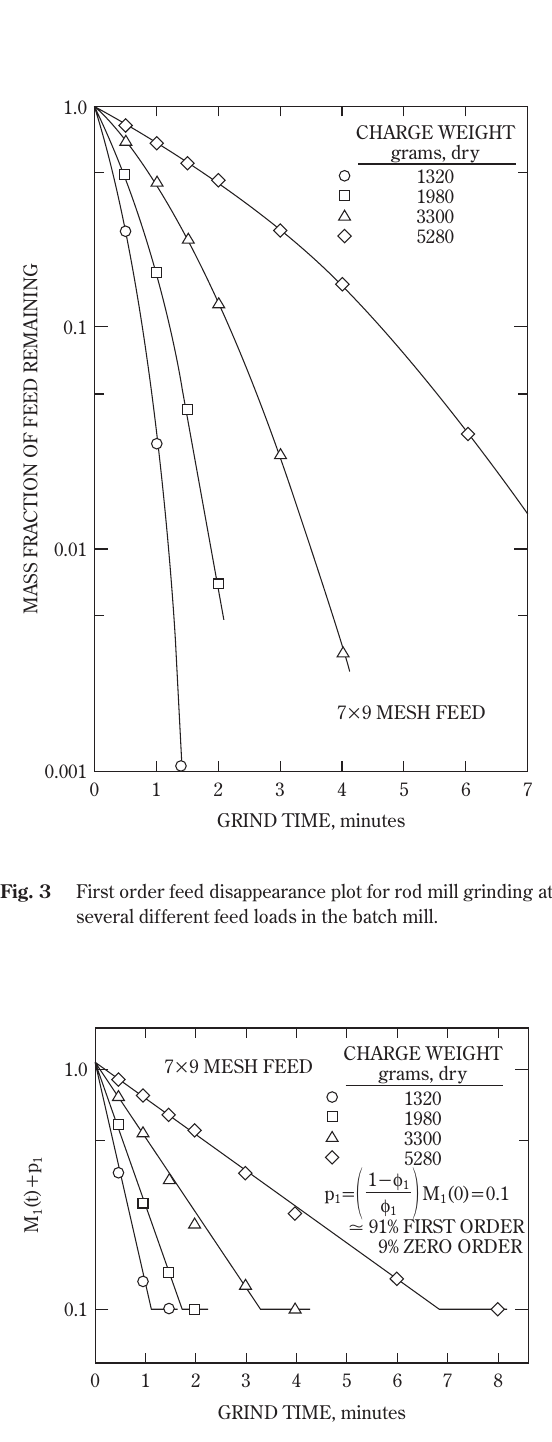
Fig. 4 Linear combination of first order and zero feed disappear- ance kinetics in dry rod